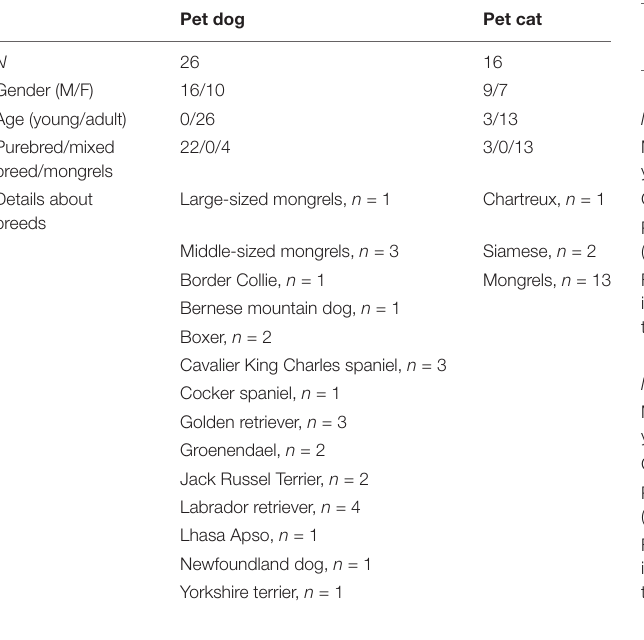
TABLE 2 | Characteristics of the sample population of children.